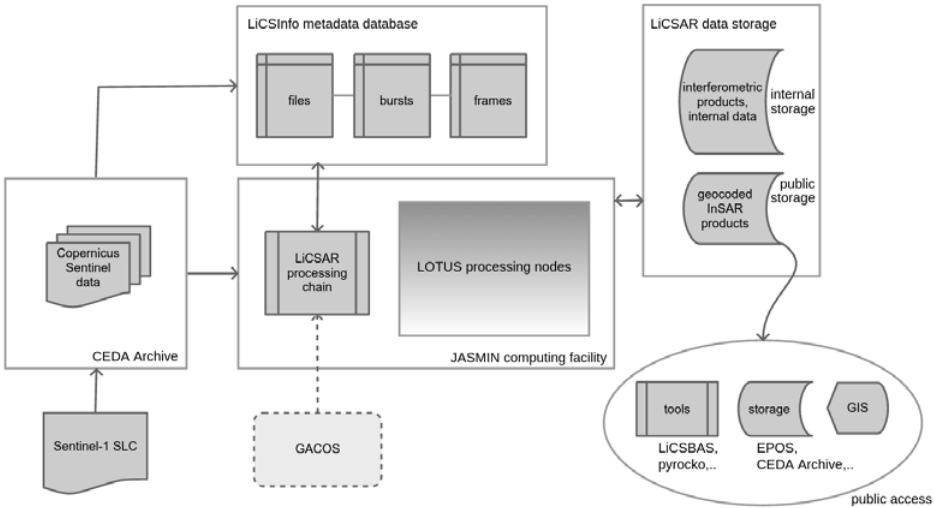
Figure 1. General overview of Looking Into Continents from Space with Synthetic Aperture Radar (LiCSAR) system architecture: interconnections between storage and computing structures leading the path from Sentinel-1 SLC acquisition to publicly accessible geocoded interferometric products.